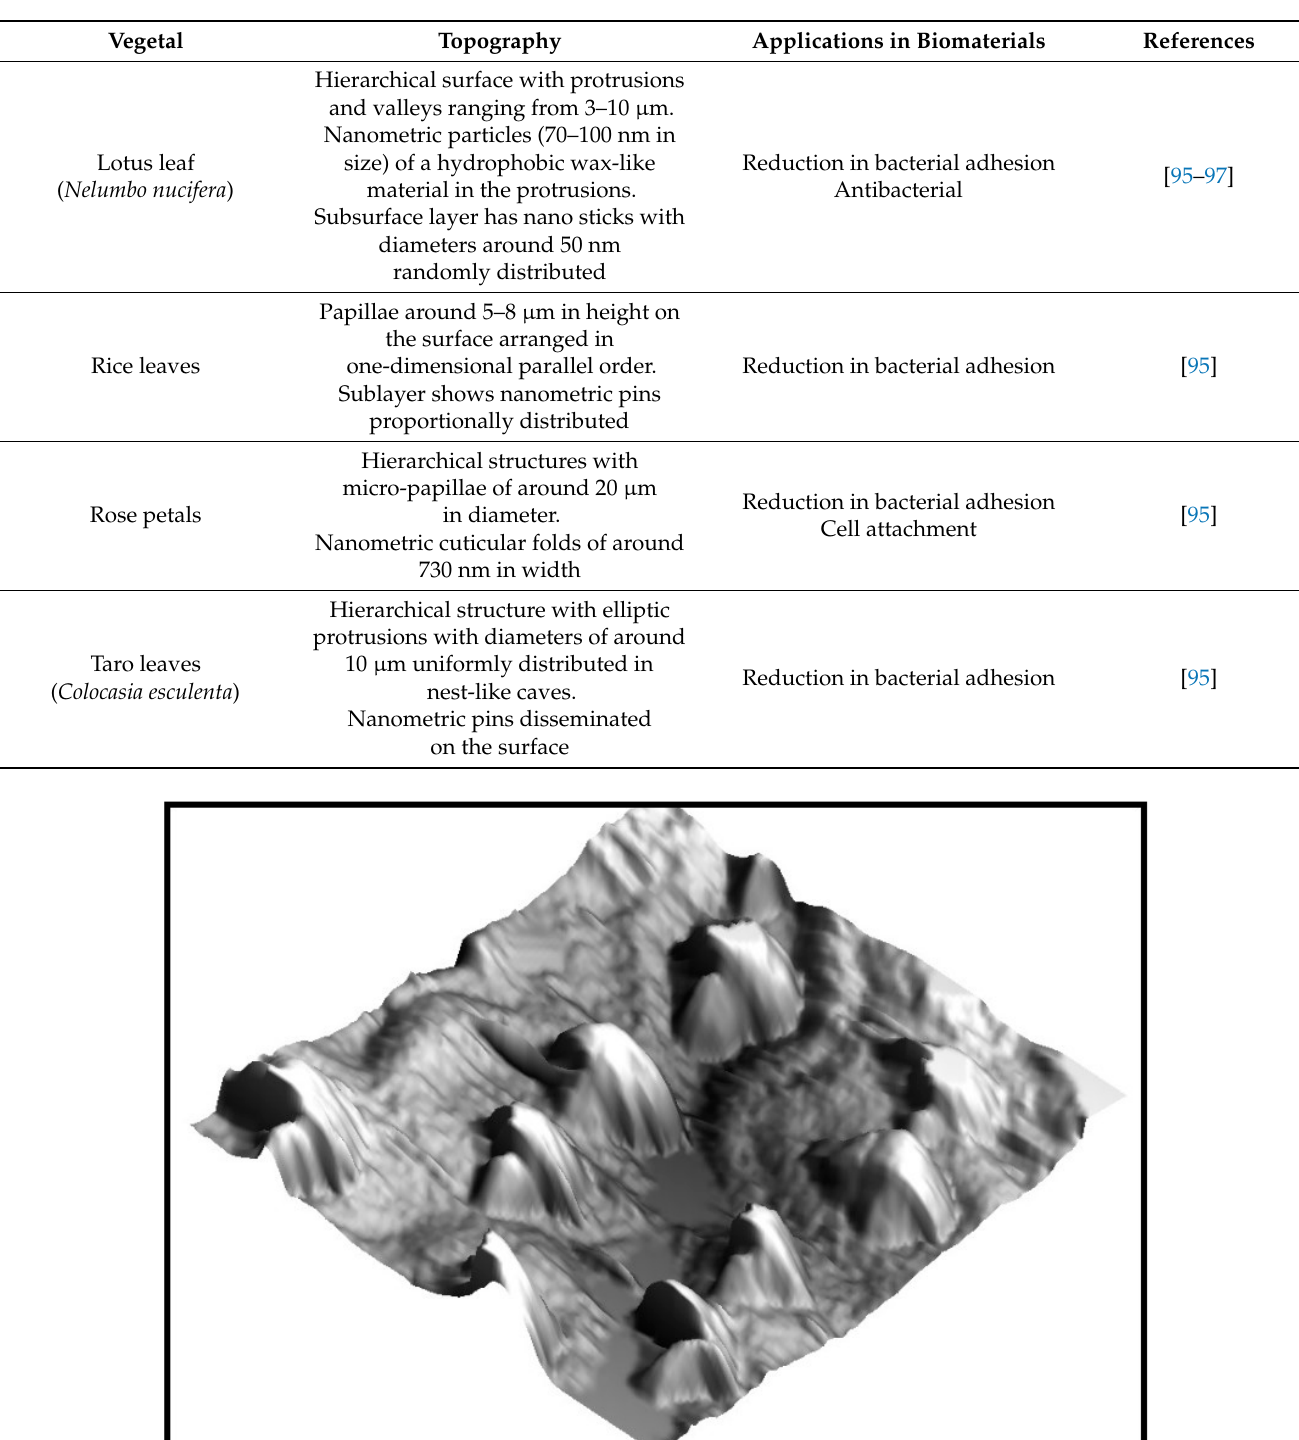
Table 2. Topographic features and biomedical applications of different vegetal surfaces.